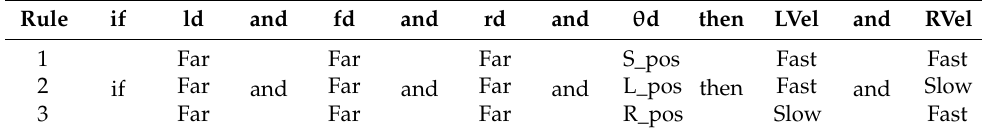
Table 2. Behavior rules for following edge of obstacles motion in navigation. Table 1. Behavior rules for target steering motion in navigation.